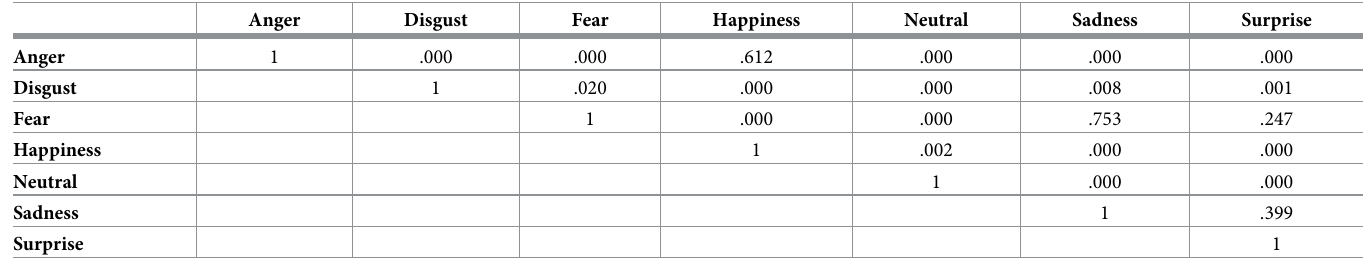
Table 21. Pairwise Dunn’s test for Phase 1 emotions.